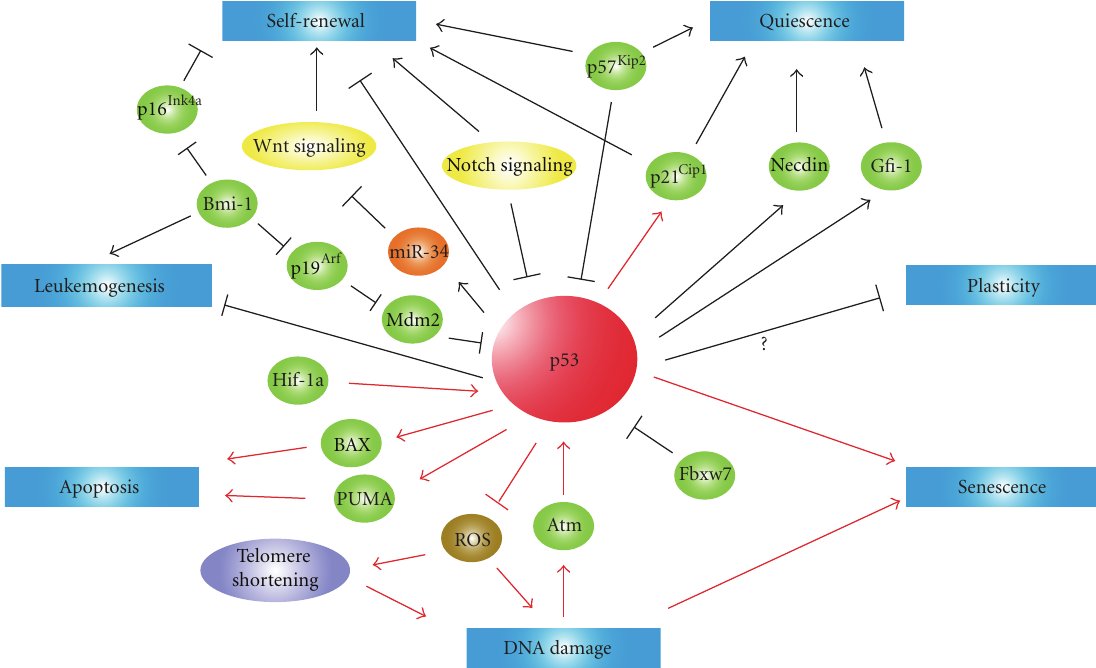
Figure 4: Schematic diagram of p53 roles in HSCs. p53 is involved in the control of response to DNA damage, self-renewal, quiescence, apoptosis, senescence, leukemogenesis, and plasticity in HSCs. Lines with an arrowhead indicate promotion and lines with a bar inhibition in steady state (black) or stress conditions